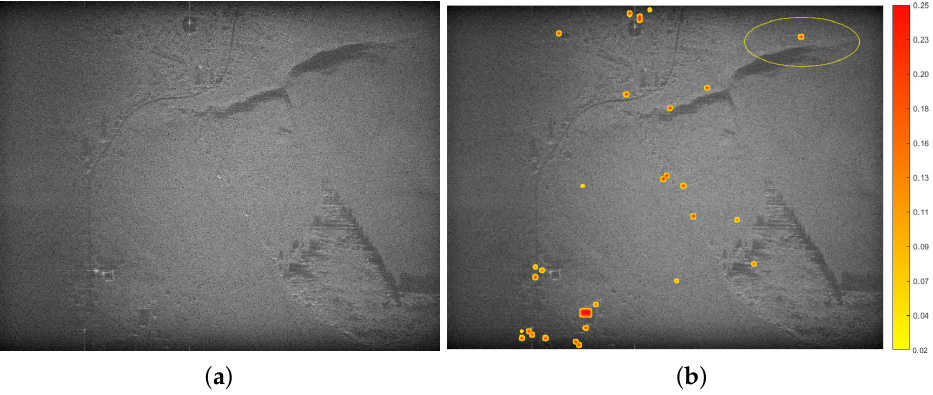
Figure 9. ( a ) SAR image of scene 1. ( b ) Uncertainty heat map superimposed onto scene 1, where the yellow ellipse contains low-certainty clutter detection.